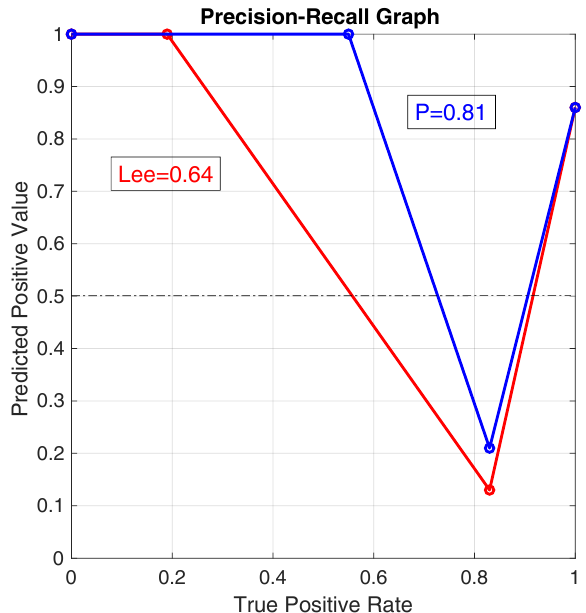
Figure 12. Precision recall graph for the two approaches with three-levels step classification. (Lee): Lee’s approach; (P): Proposed approach.